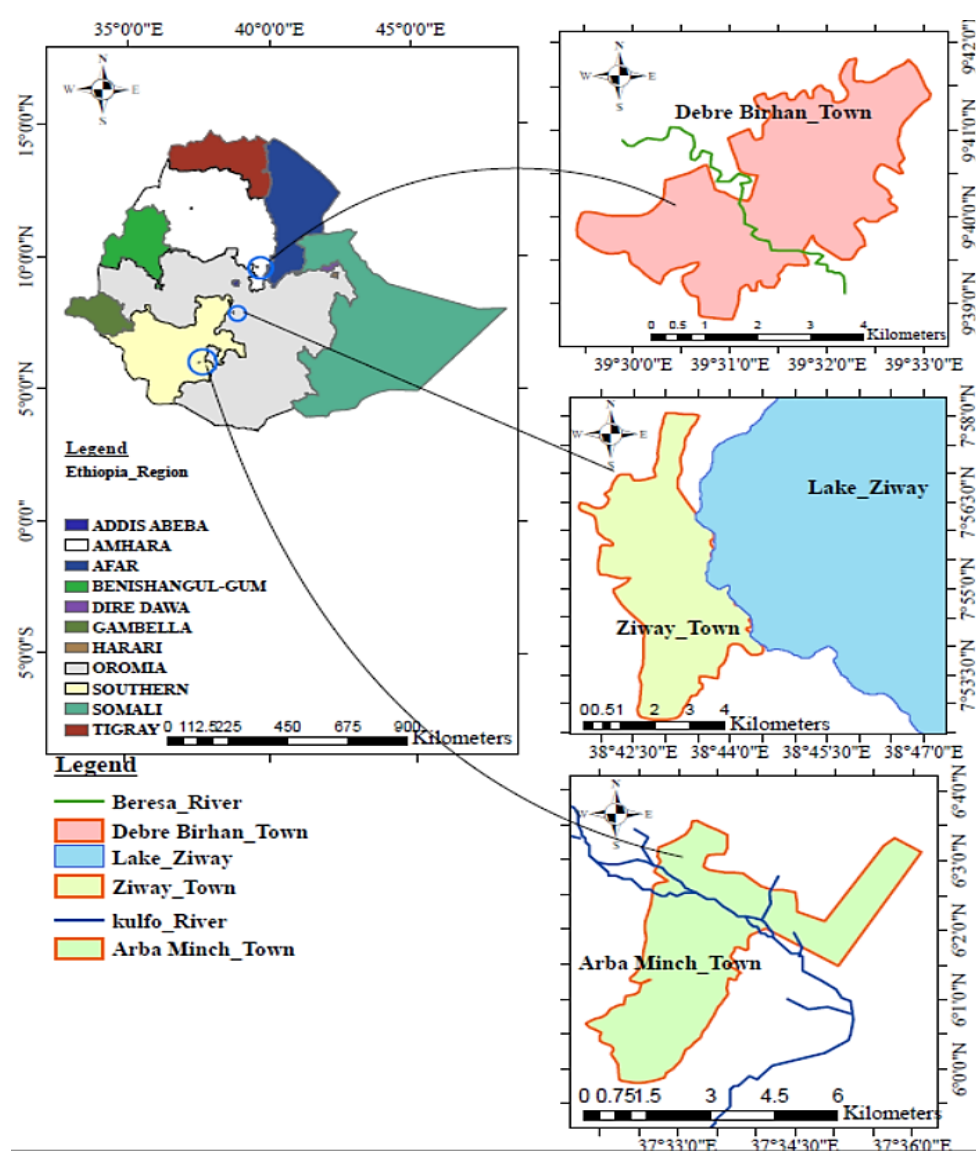
Figure 1. Study area locations in Ethiopian map.